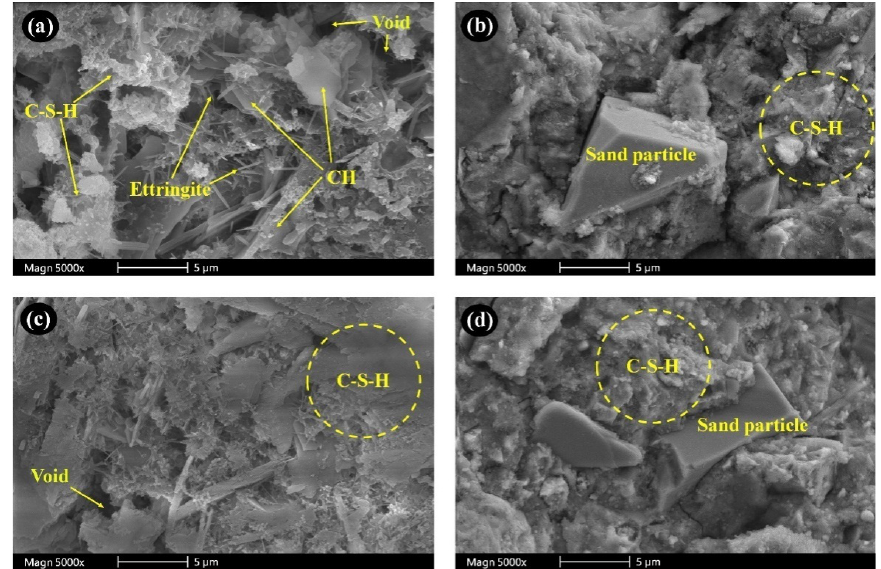
Figure 9. SEM images of ( a ) control, ( b ) W1/20, ( c ) W2/20, and ( d ) W3/20 mortar specimens at 28 days.